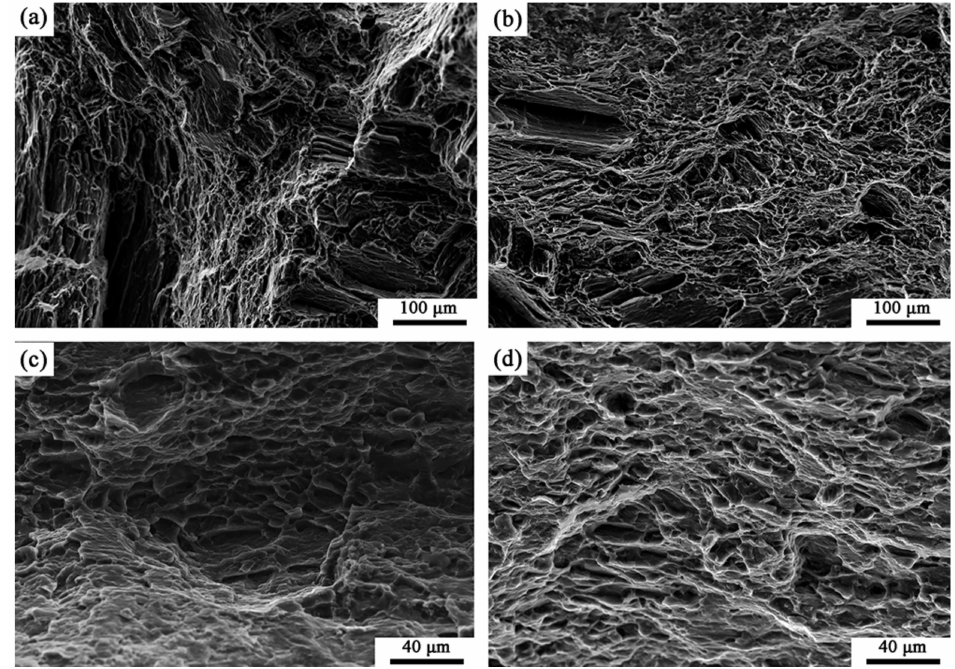
Figure 16. The fracture morphologies of the AZ31B alloys: ( a ) as-cast, CEE-AEC-processed for 1 pass ( b ), 2 passes ( c ) and 3 passes ( d